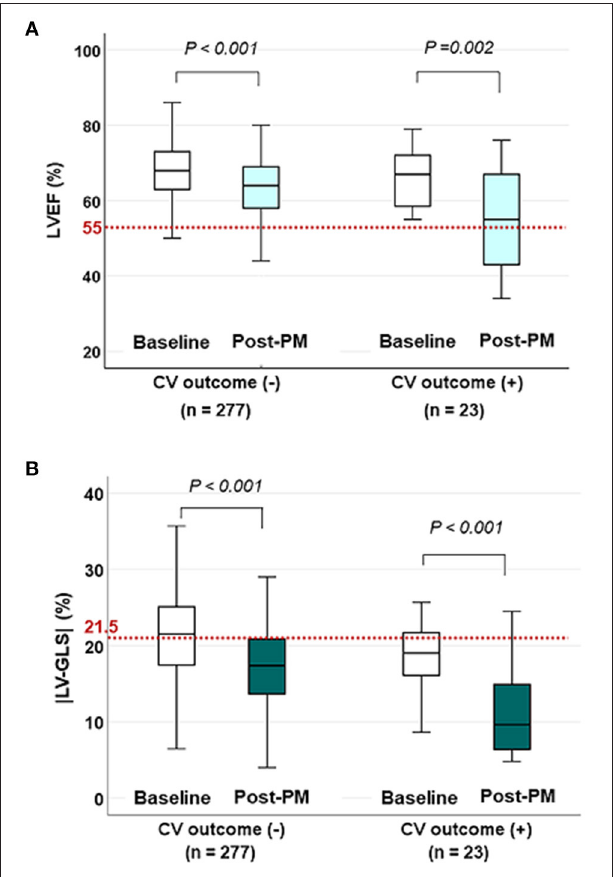
FIGURE 2 | The changes in LVEF and |LV-GLS| according to CV outcomes on baseline and post-PM echocardiogram. (A) LVEF decreased after PM implantation in both groups, but the mean values were within the normal range (red dotted line) even in patients with CV outcomes. (B) |LV-GLS| in patients with CV outcomes decreased more noticeably than in patients without CV outcomes under normal values (red dotted line). LVEF, left ventricular ejection fraction; CV, cardiovascular; |LV-GLS|, absolute value of left ventricular global longitudinal strain; PM, pacemaker.